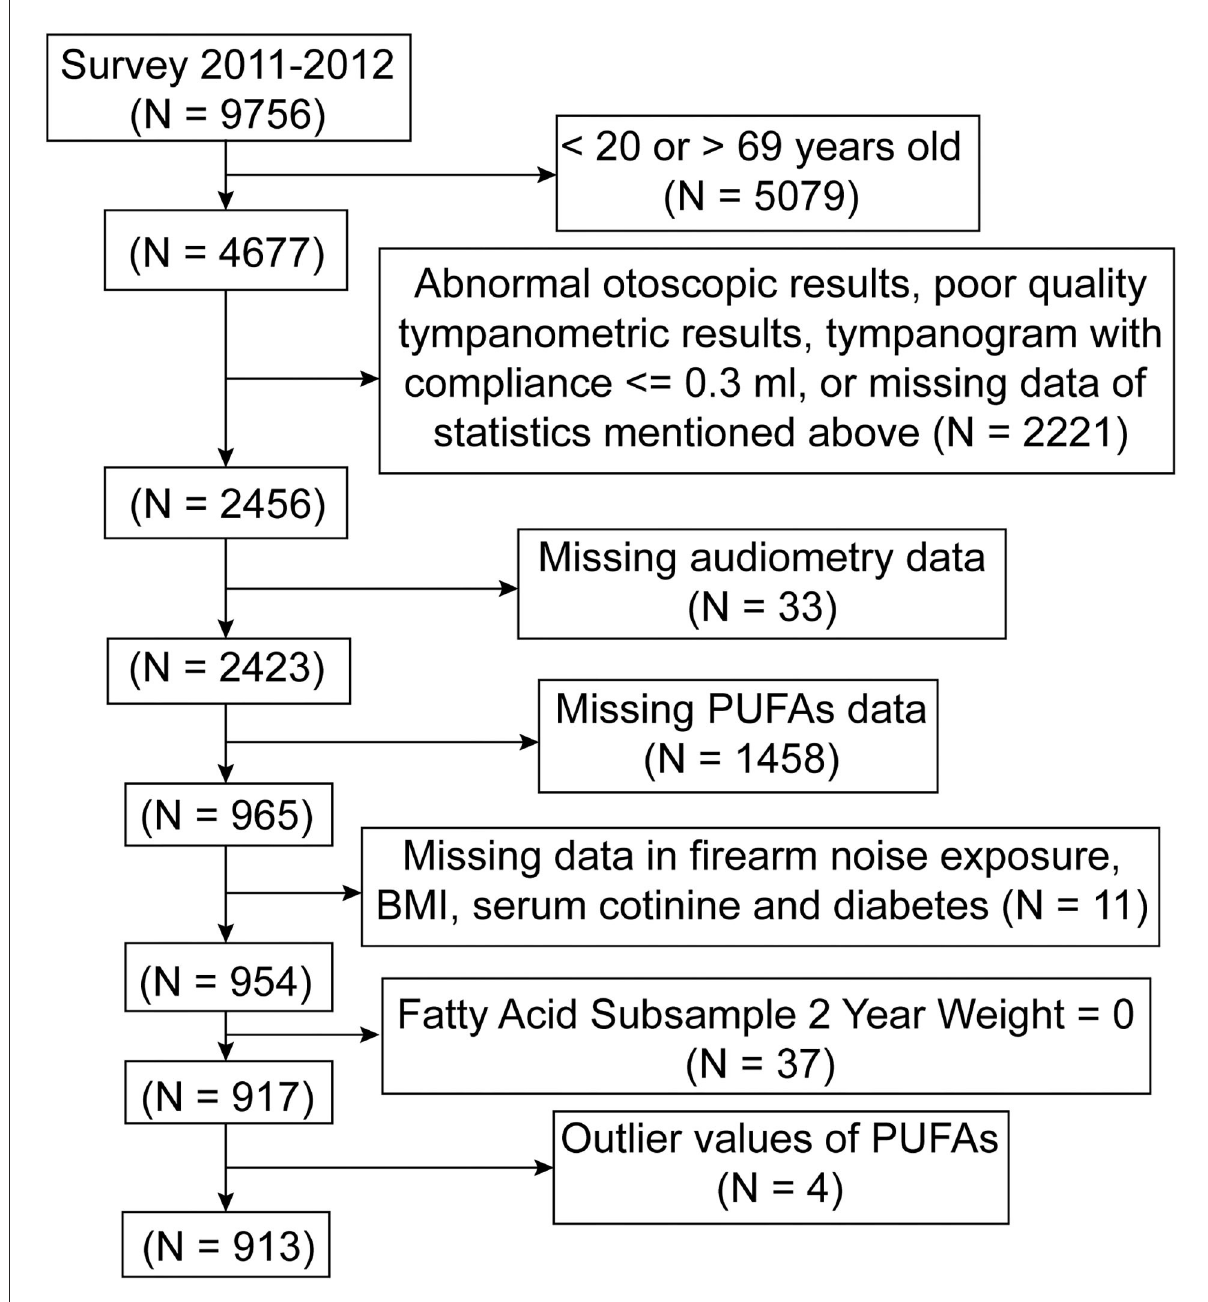
FIGURE1 Flow chart of the patient selection process. NHANES, National Health and Nutrition Examination Survey.